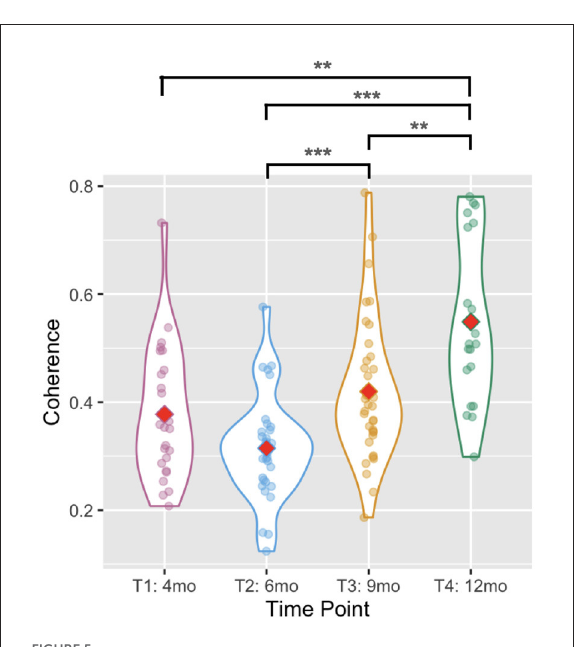
FIGURE5 Violin plots showing the between-arms coherence. Red diamonds indicate mean values. Two asterisks indicate p < 0.01, and three indicate p < 0.001.